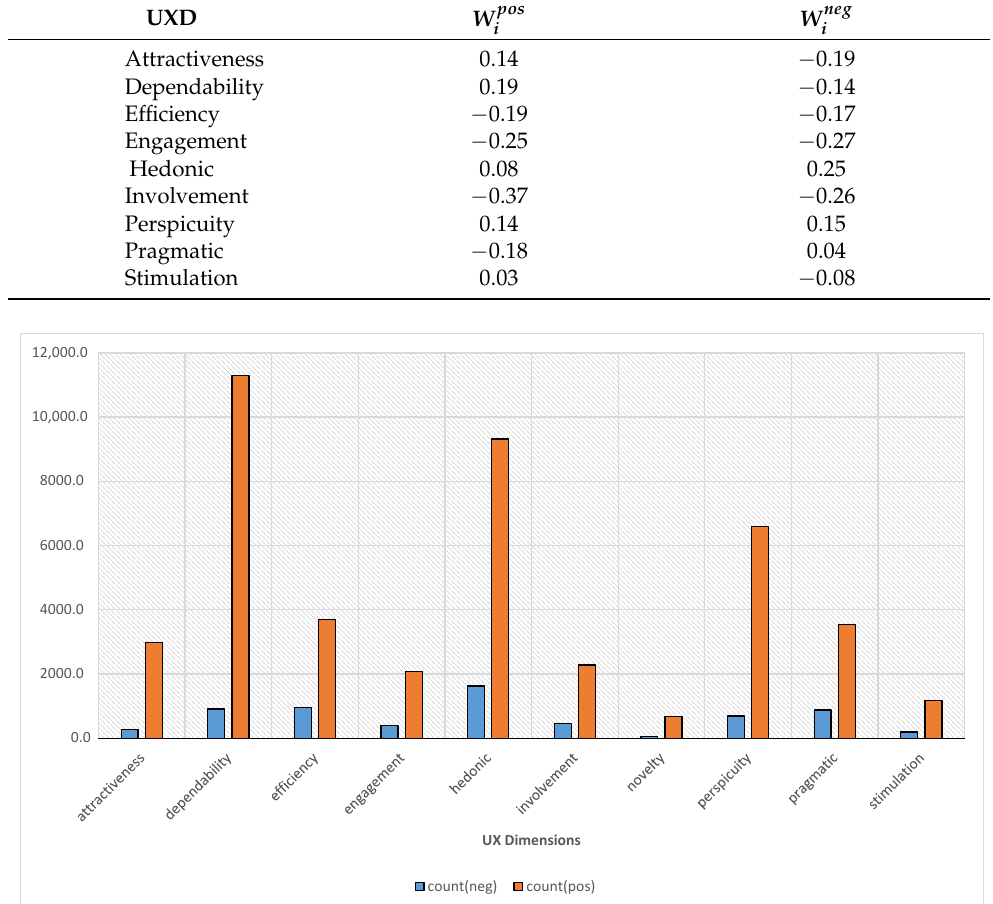
Figure 16. The sentiment orientations result towards each extracted UXD.